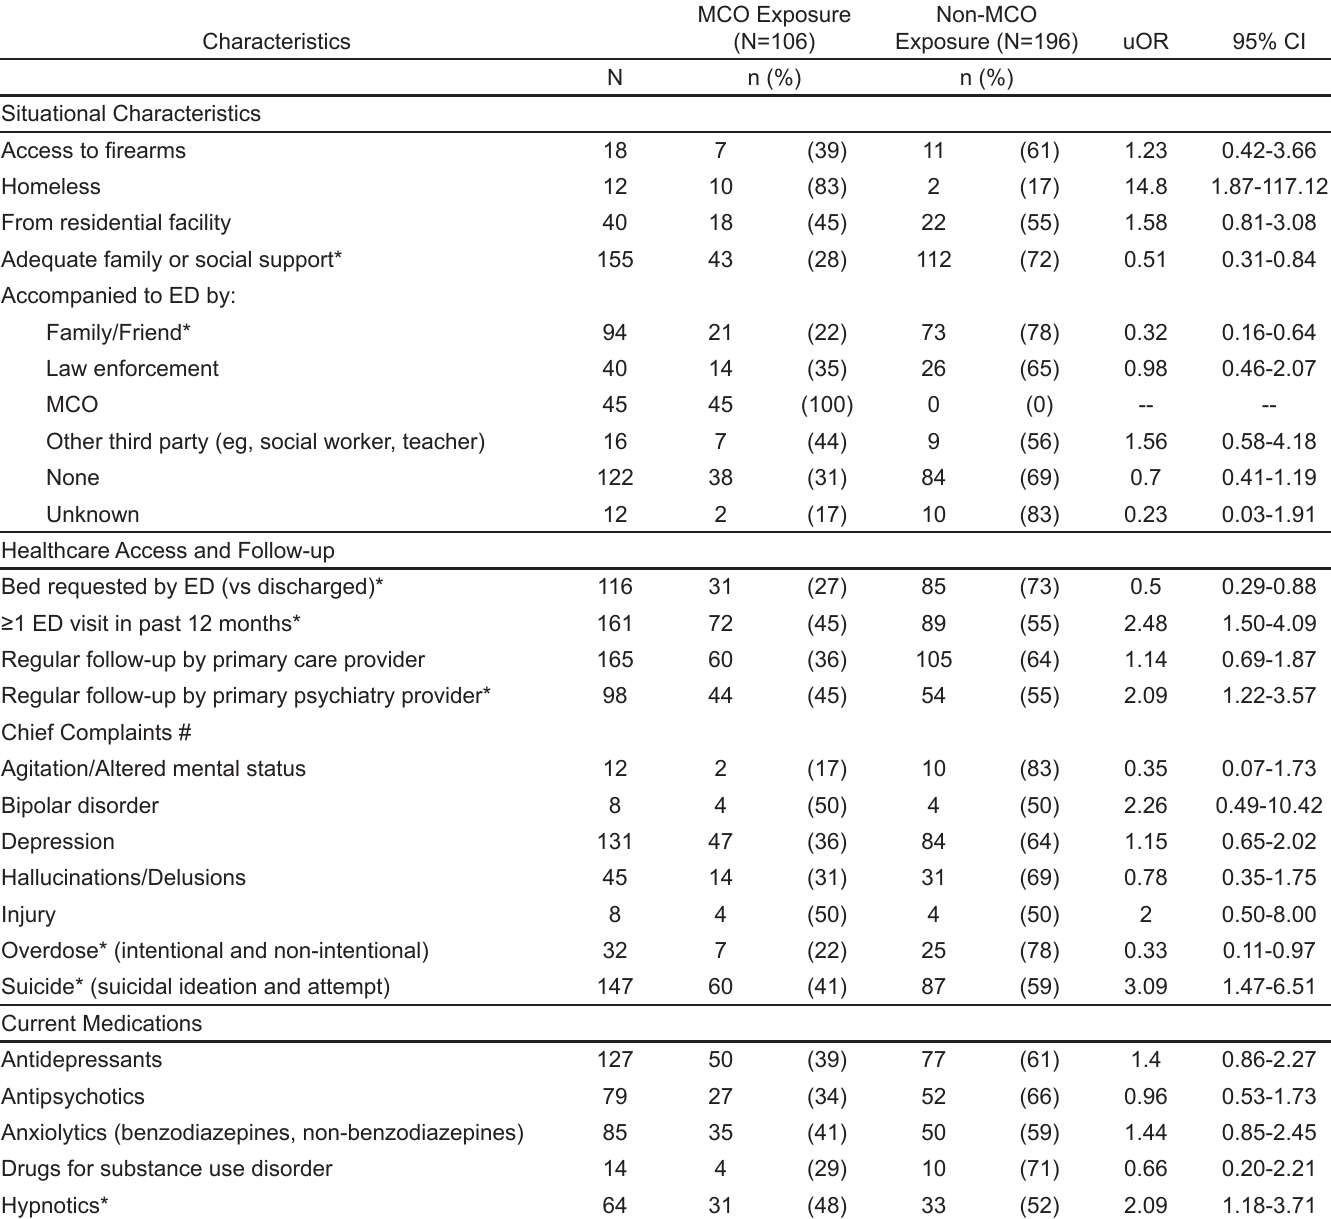
Table 2. Comparison of situational, clinical characteristics, and healthcare access and follow-up between cohorts with and without exposure to mobile crisis